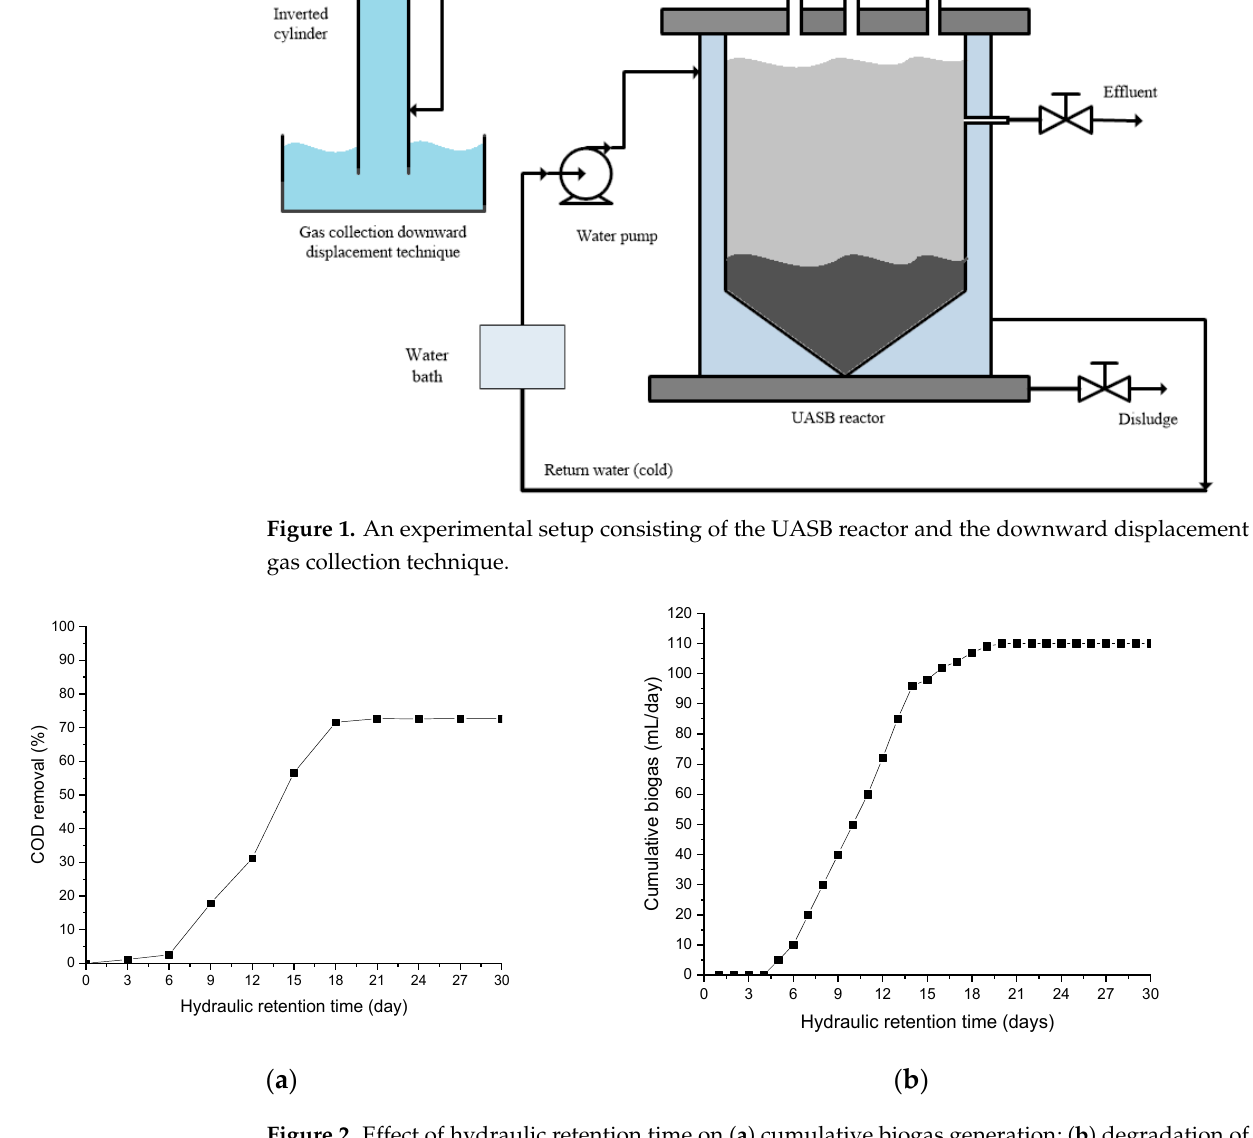
( b ) Figure 3. E ff ect of magnetite load on ( a ) cumulative biogas for the duration of AD; ( b ) daily biogas production. It is clear that the production of biogas at the start of the period for all the digester systems varies with the amount of magnetite loaded. The amount of time it takes for microorganisms to adjust to their new environment is determined by the fi rst steady rise of biogas accumulation, which is commonly referred to as the lag phase period (acclimatize) [27]. As evident from the graph in Figure 3a, the control has a lag phase of 5–6 days, suggesting that it takes longer for the microorganisms to fully adapt to the traditional AD system. The use of magnetite is found to reduce the lag phase of the AD process. This is because the use of magnetite in anaerobic digestion improves the interspecies electron transfer, which ultimately enhances biogas production [19,25,28].